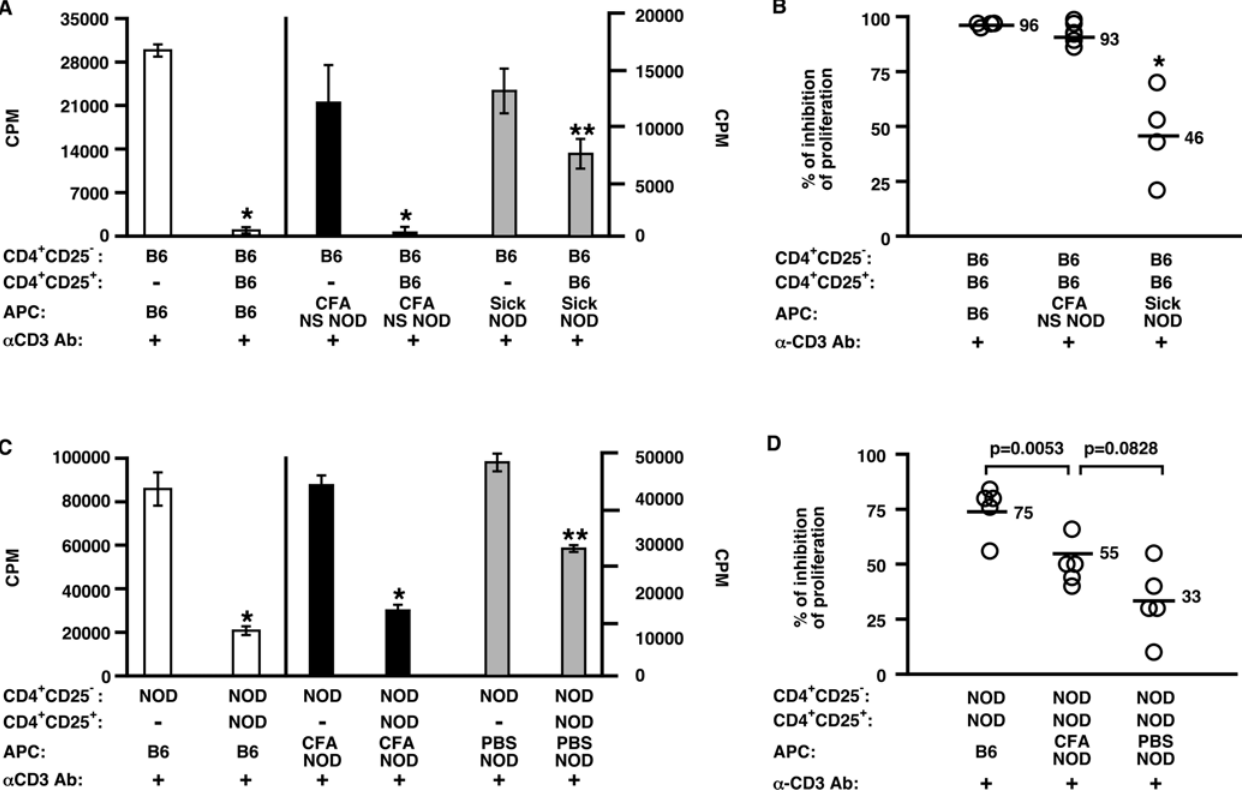
Figure 3. APC from CFA-treated NOD mice effectively induce regulatory cell function invitro . CD4 + CD25 2 responder cells from B6 mice were cultured with irradiated spleen cells (APC) from individual 30 week-old B6, Non-Sick (NS) CFA-treated or Sick NOD mice, anti-CD3 and either with or without CD4 + CD25 + cells from B6 mice (1:1 regulatory:responder ratio; A & B). CD4 + CD25 2 responder cells from NOD mice were cultured with irradiated spleen cells (APC) from individual 11 week-old NOD mice injected with PBS or CFA three weeks earlier or B6 mice, anti-CD3 and either with or without CD4 + CD25 + cells from NOD mice (1:1 regulatory:responder ratio; C & D). Raw cpm data are shown for one representative animal (A & C), and percent inhibition is shown where each point represents an individual animal (B & D). * and ** indicate significant differences from the respective proliferation controls (i.e., responders alone; A & C), or B6 APC (B) at p , 0.001 and p , 0.05, respectively.